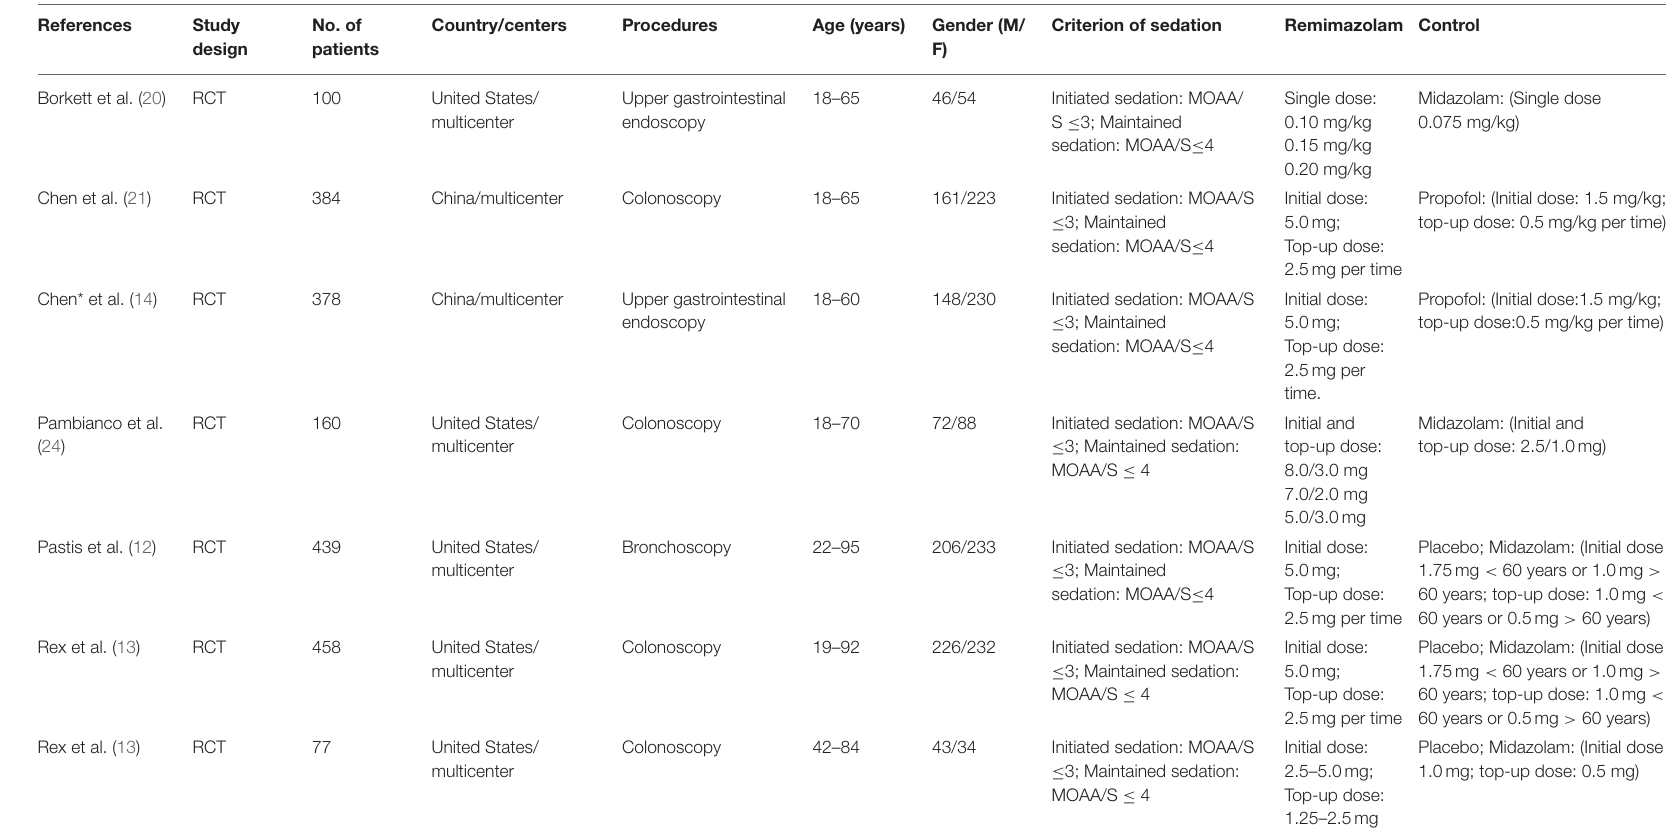
TABLE 1 | The basic characteristics of included studies.